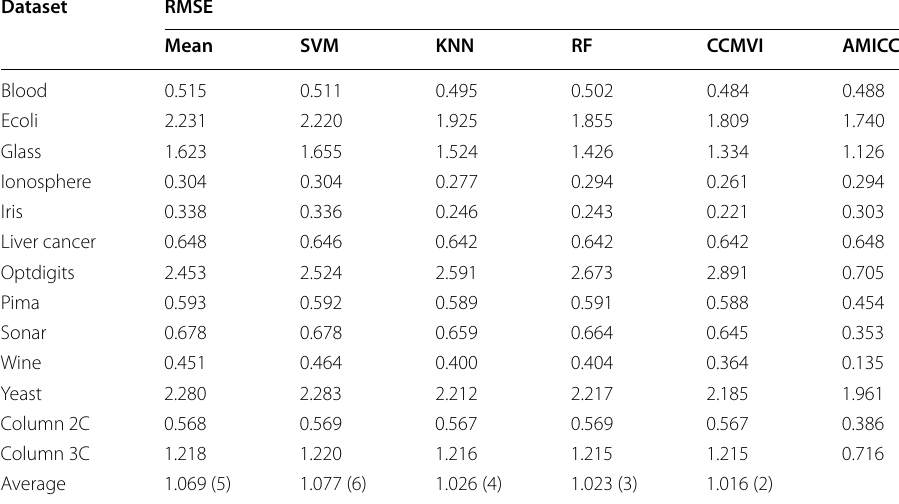
Table 10 Average RMSEs of the MVI methods for the numerical datasets